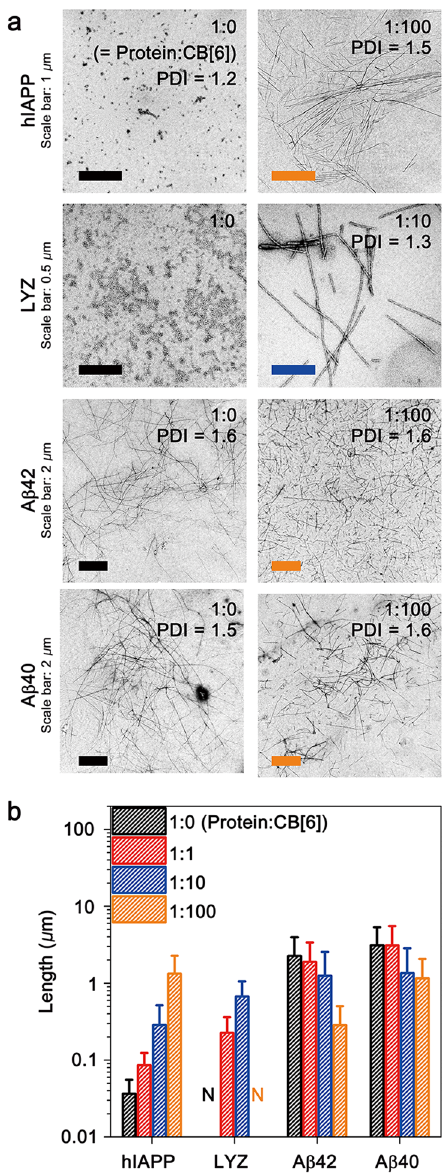
Figure 4. General applicability of CB[6] in the control of various amyloid fibrils. ( a ) TEM images of hIAPP, LYZ, A β 42, and A β 40 fibrils. ( b ) Lengths of amyloid fibrils controlled by CB[6]. The concentration of LYZ was 50 μ M, and those of hIAPP, A β 42, and A β 40 were 10 μ M. Numerical values of the fibril lengths and PDI are available in Supplementary Table